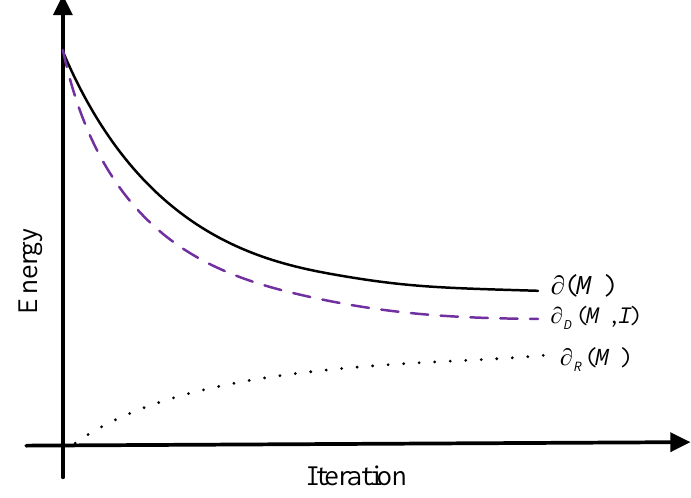
Figure 1. The evolution process of energy functional.